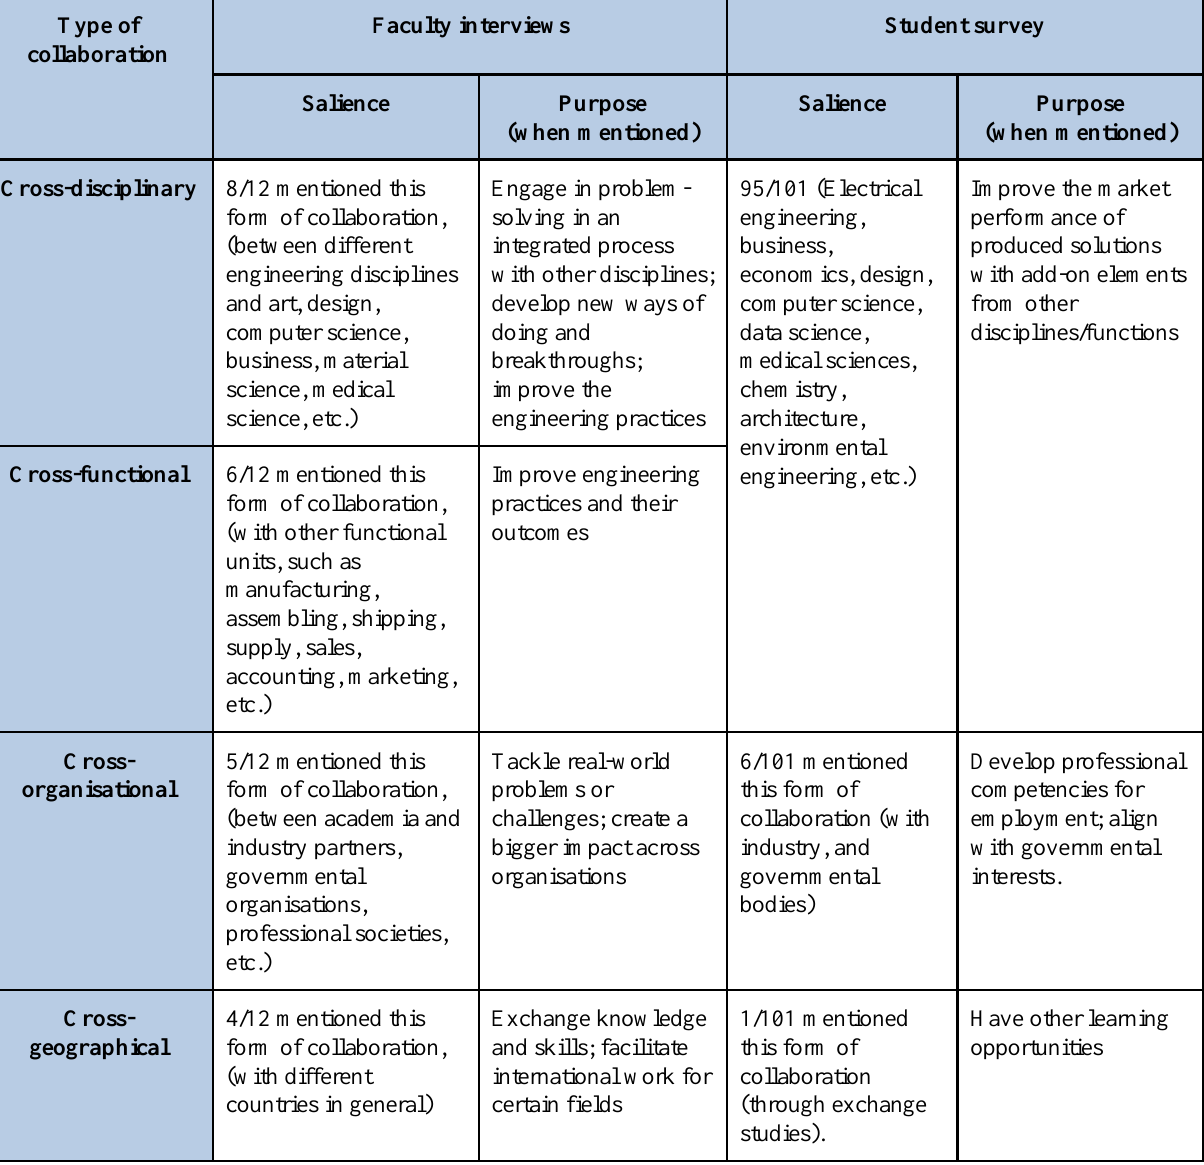
Table 1. Types and purposes of collaboration brought up by engineering faculty and students Type